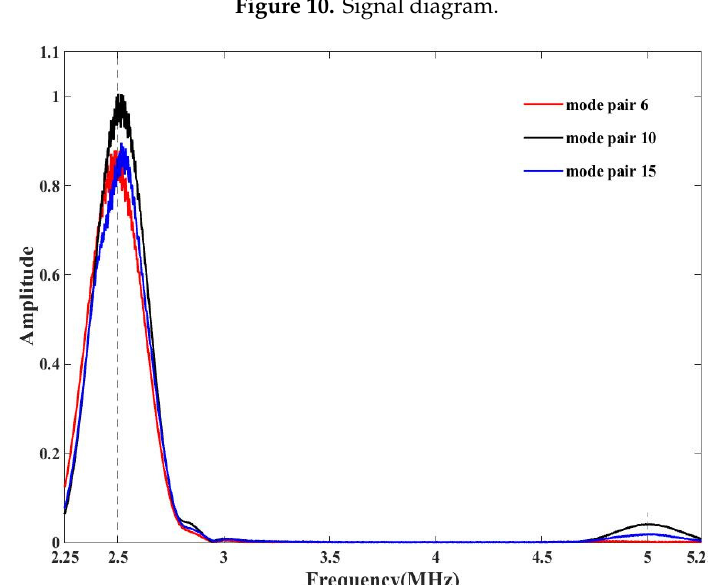
Figure 10. Signal diagram. Appl. Sci. 2020 , 10 , x